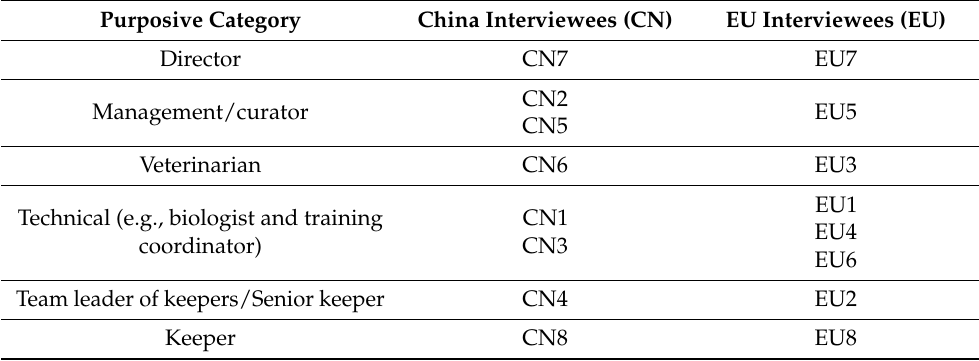
Table 1. Matrix of maximum variation purposive sample of European (EU) and Chinese (CN) interviewees. Each interviewee was anonymised via a unique identifier representing the region of origin combined with a number indicating the chronology of interviews (1–8). Purposive Category China Interviewees (CN) EU Interviewees (EU) Director CN7